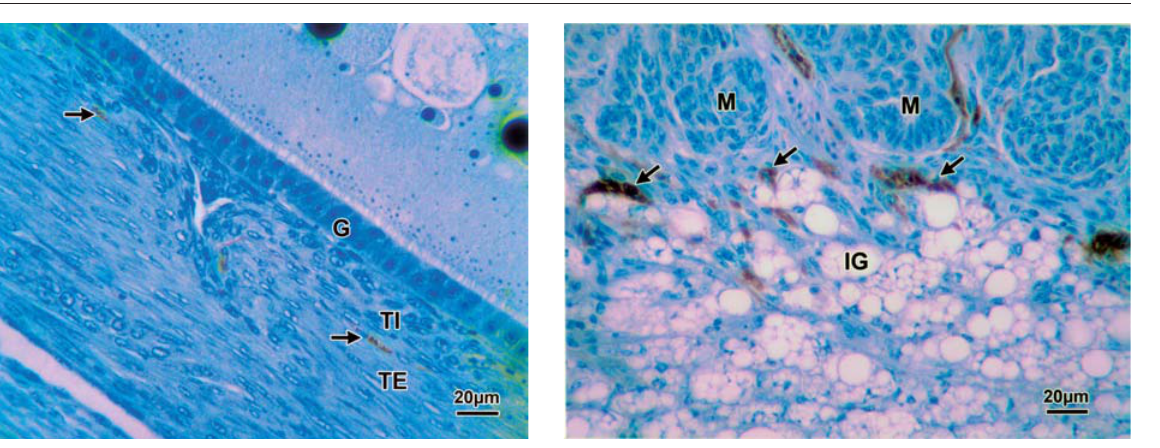
FIG. 7 PGP 9.5 immunopositive nerves (arrows) in the theca externa (TE) of a developing vitellogenic follicle. TI: theca interna. G: granulosa cell layer